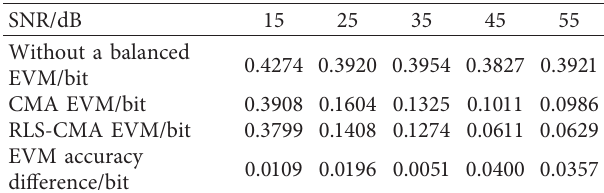
Figure 15: 16PSK EVM curves. Table 1: EVM values obtained by different blind homogeneous algorithms for the BPSK-modulated signals.